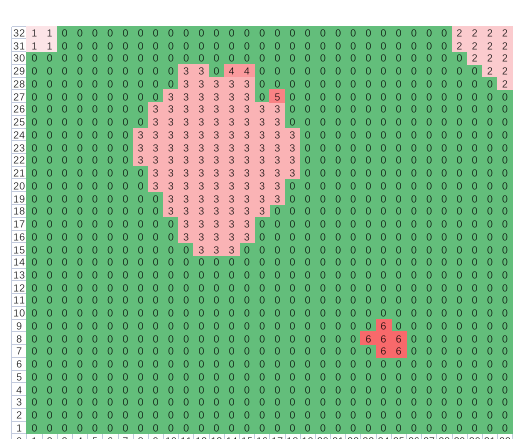
Figure 10. Every point is labeled with a block number after the first boundary scan.